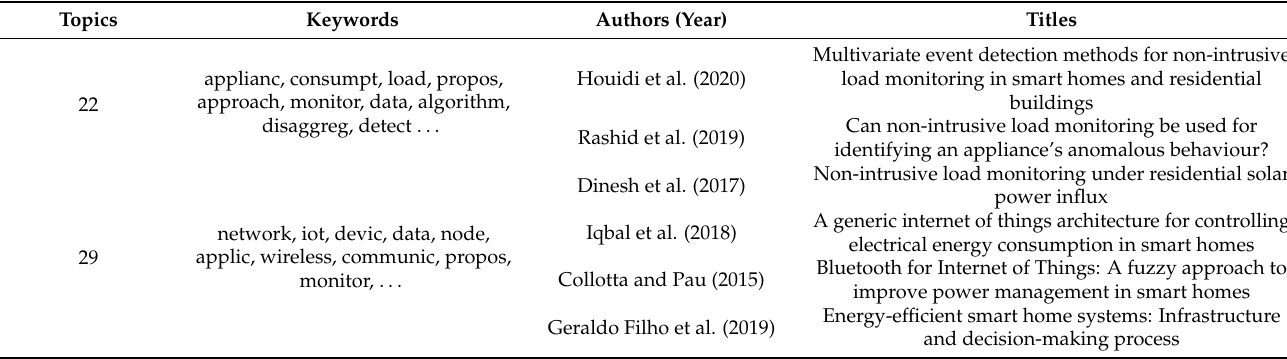
Table 2. Relevant documents with Strong signal topics 1